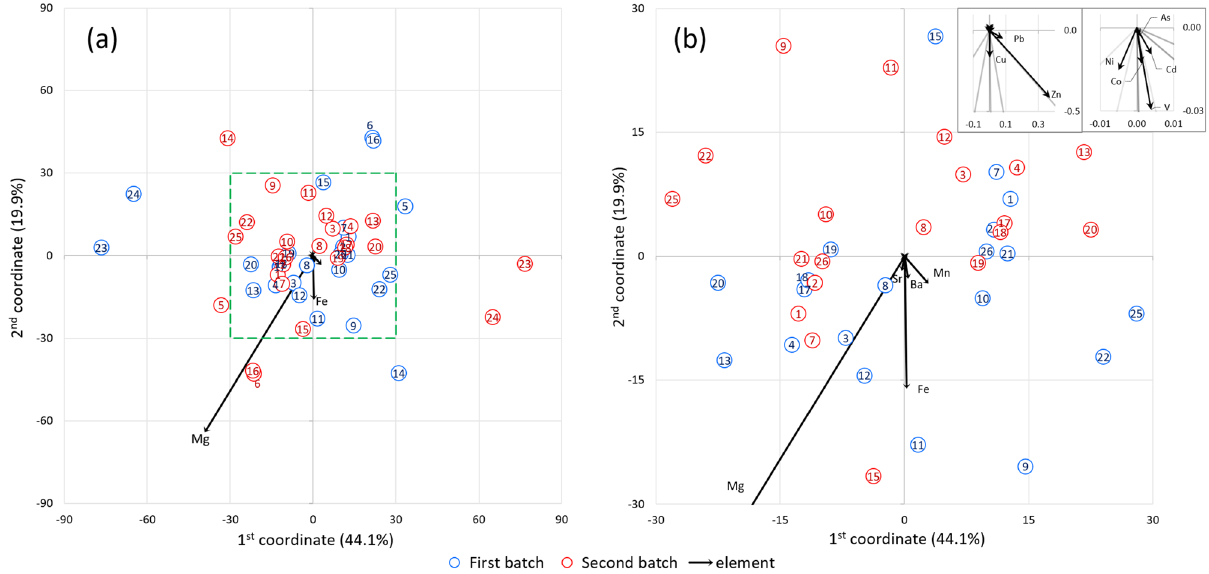
Figure 2. The projection of interaction effects. Projection of objects on space defined by 1st and 2nd coordinate in relation to the elements in full scale ( a ) and zoomed section ( b ) outlined by the green dashed line. The two data sets represent the herbs purchased 1 year apart. The points for the same herb roots from different batches are drawn in equal distances and on the opposite sides relative to the origin. The zoomed section of the origin in upper right corner shows the direction of smallest arrows related to